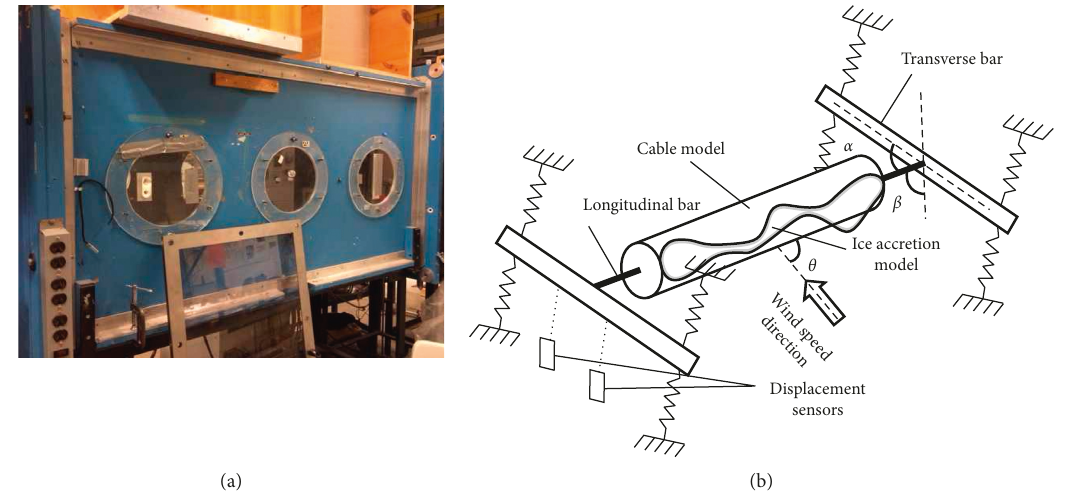
Figure 1: (a) Suction wind tunnel facility; (b) spring suspension system.